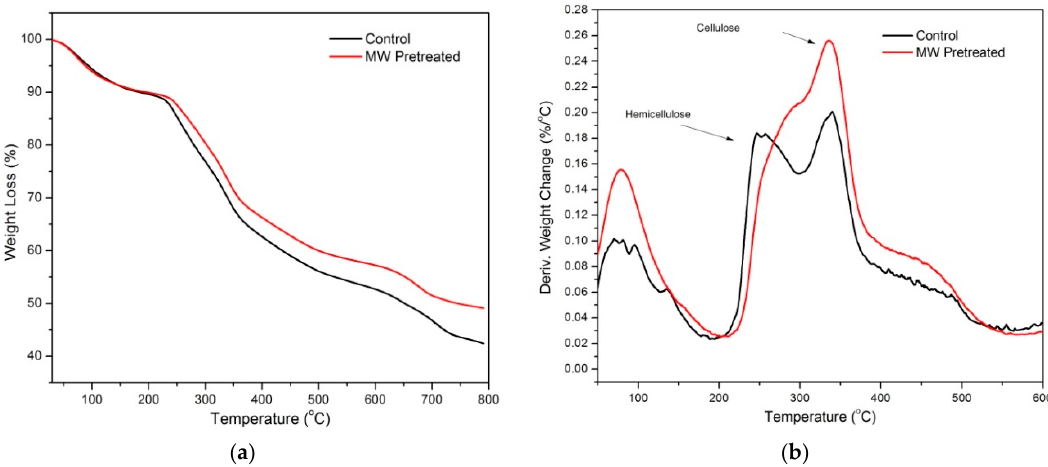
Figure 1. Biogas production influenced by microwave ( MW) pretreatment and its combination with Fe 3 O 4 nanoparticles (NPs).